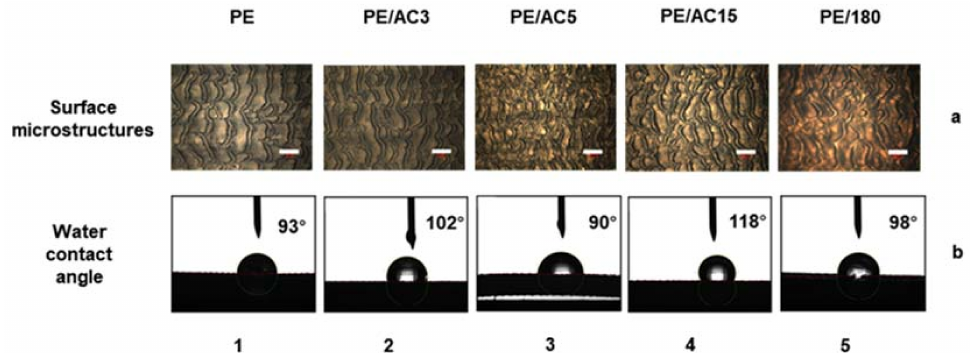
Figure 4. ( a ) The morphology and water contact angle of samples prepared with different additives in ( b ) micrometer scale. ( a ) The scale bar in the illustration was 400 µ m. (1–5) respectively showed no additives, AC3, AC5, AC15,